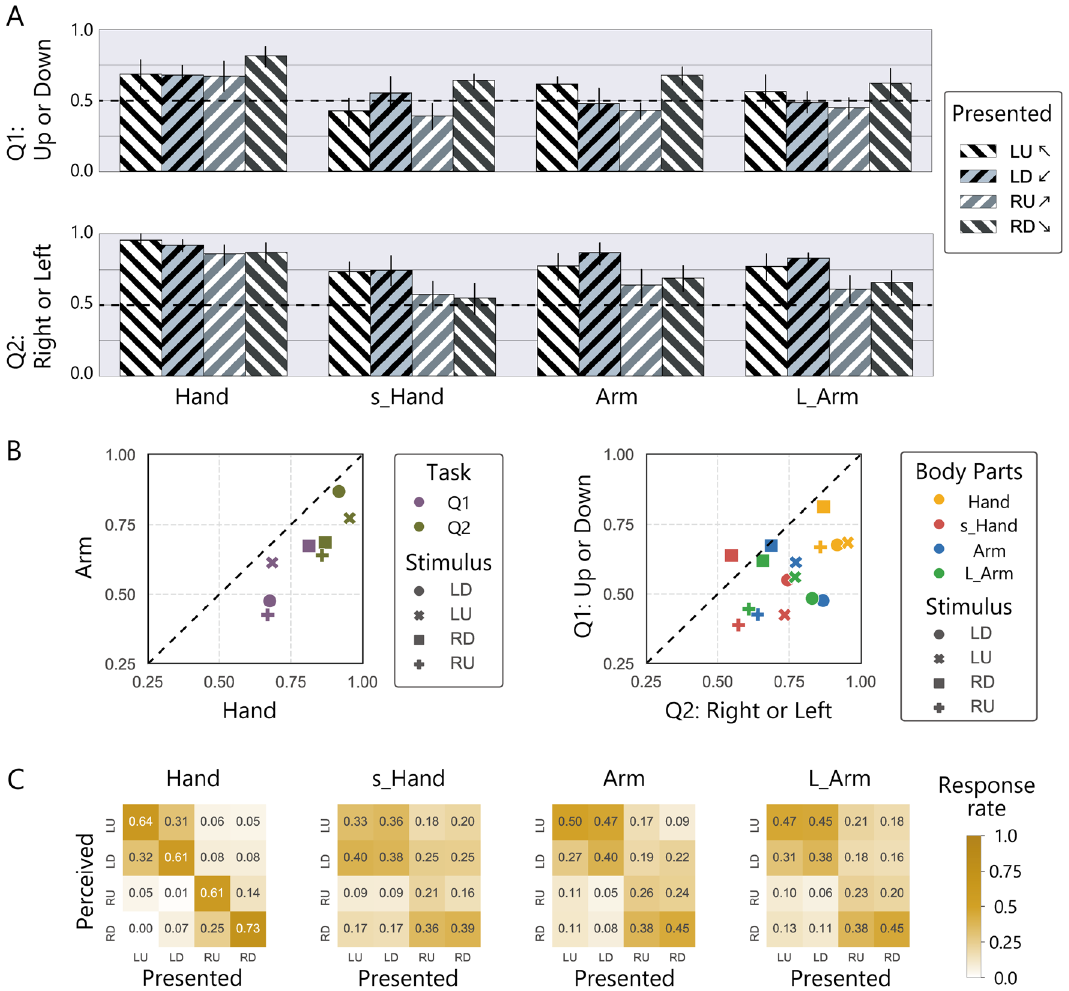
Figure 3. Results of Experiment 2 where nine scatter dots were presented and moved in the same direction. ( A ) Averaged correct rates for each 2-AFC. Error bars represent 95% CIs. ( B ) The left panel represents the relationship of performance between the hand and arm conditions. The right panel represents the relationship of performance between the two 2-AFCs. ( C ) The estimated rate of the perceived